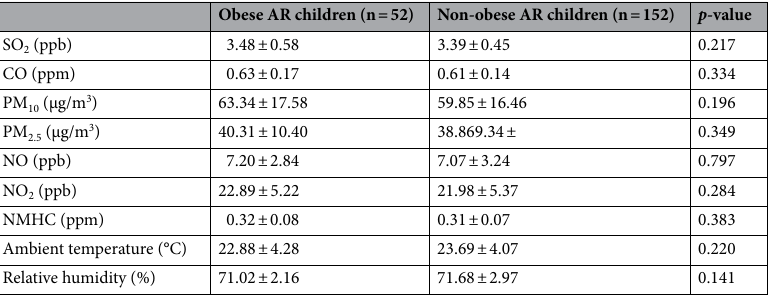
Obese AR children (n = 52) Non-obese AR children (n = 152) p -value SO 2 (ppb)